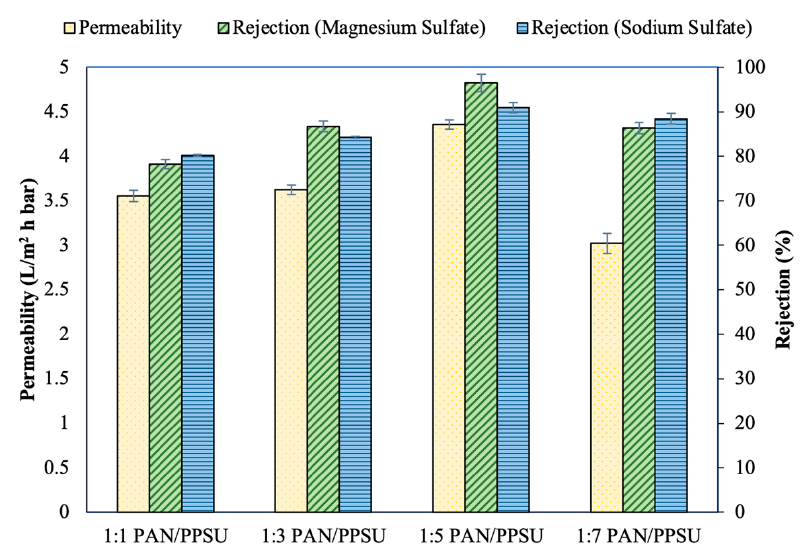
Figure 2. Permeability and salt rejection of TFC membranes made of different types of PAN/PPSU substrates without non-woven fabric (Operation mode: pressurized filtration; feed solution: 1000 ppm salt solution; operating pressure: 10 bar; temperature: 24 °C (+1)).